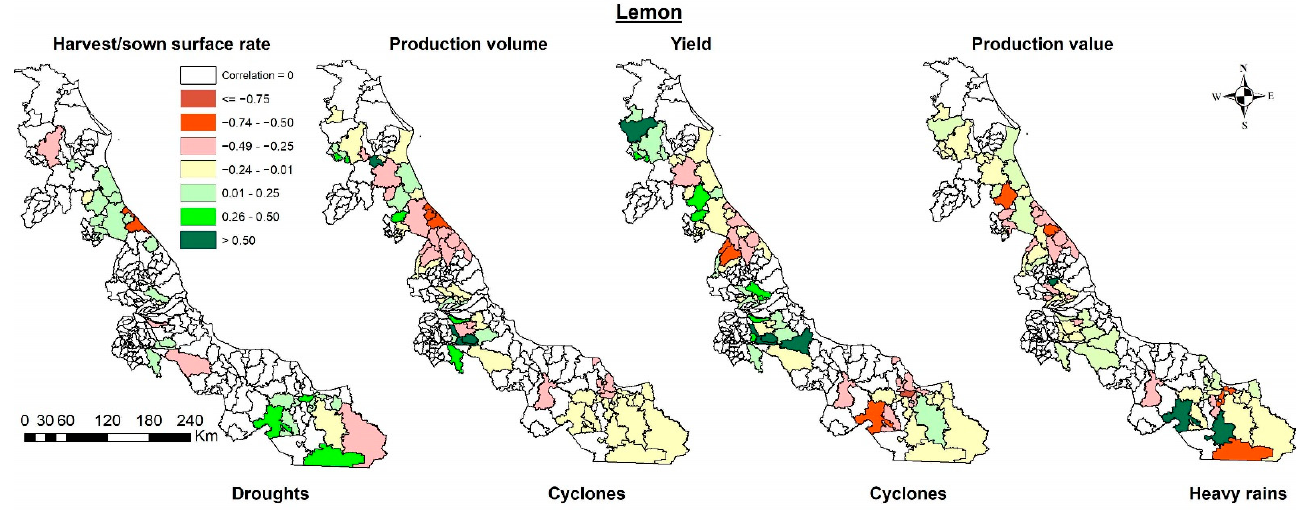
Figure 9. Lemon crop data correlated with Disaster Declarations in the municipalities of the State of Veracruz from 2003 to 2020. No correlation: sites with no correlation with phenomena. Source: projections based on data from the Mexican National Center to Prevent Disasters statistics [15] and the Mexican National Agrifood System [5].